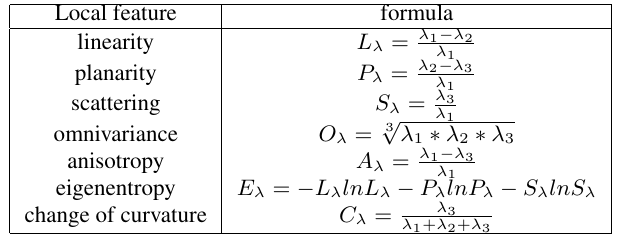
Table 2. The calculation of local